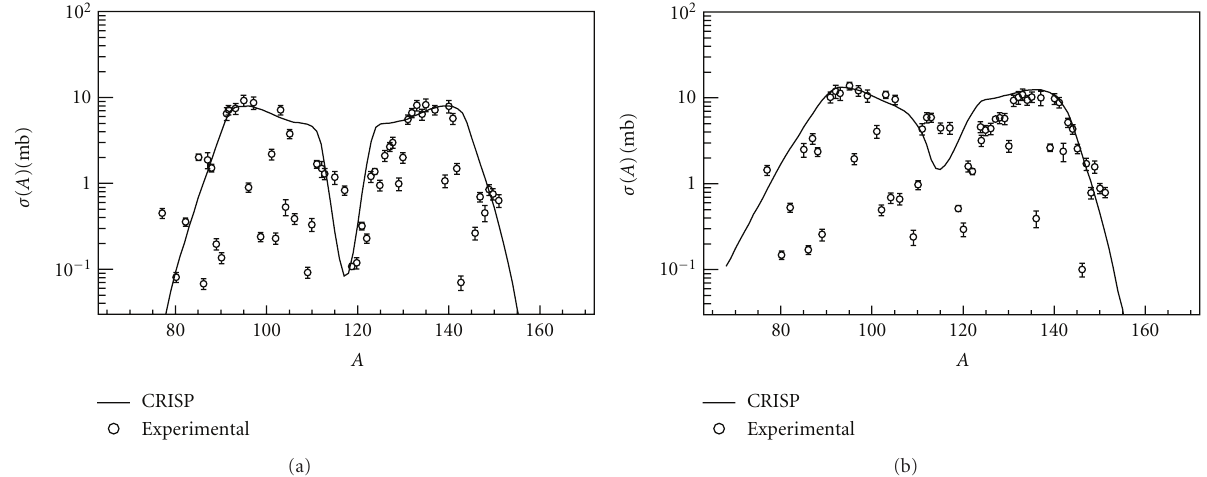
Figure 2: Cross sections for fragments produced in the fission of 238 U induced by bremsstrahlung of 50MeV (a) and 3500 MeV (b) endpoint energies as a function of fragment mass. Open circules ( ◦ ) are experimental results [11].